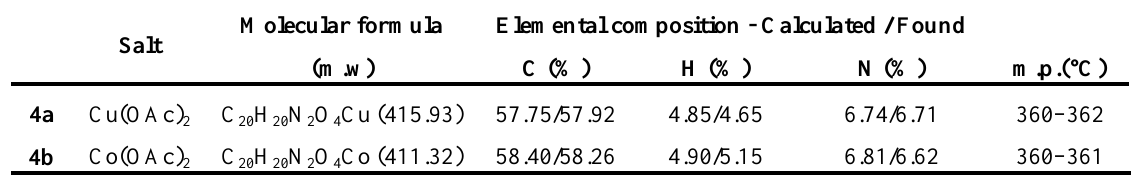
Table 4. Microanalysis data for compounds 4a ,